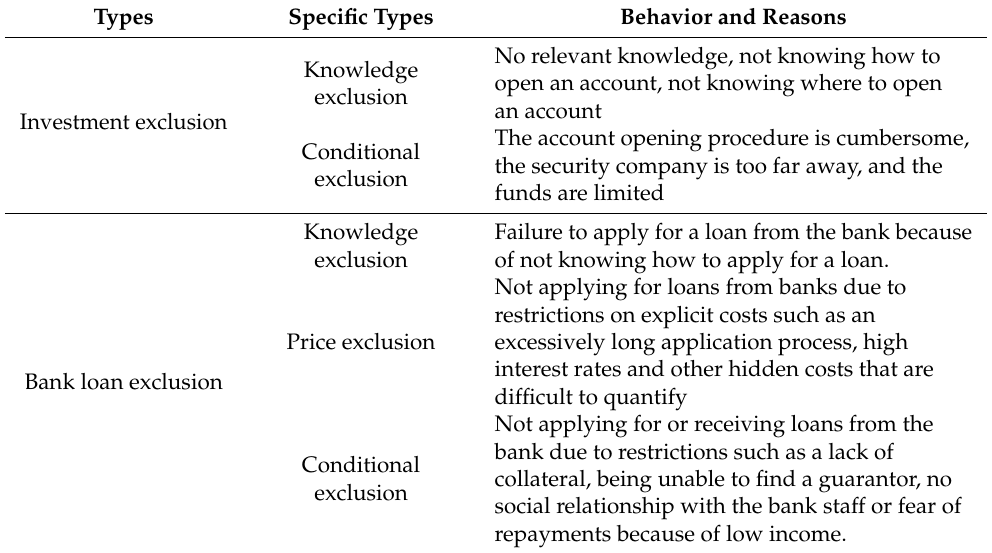
Table 2. Types, performance, and reasons for farmer households’ financial